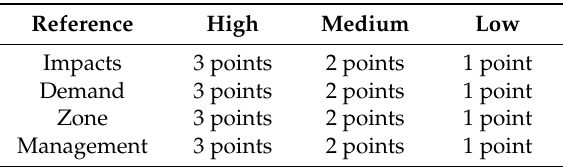
Table 3. Reference standard and intensity of